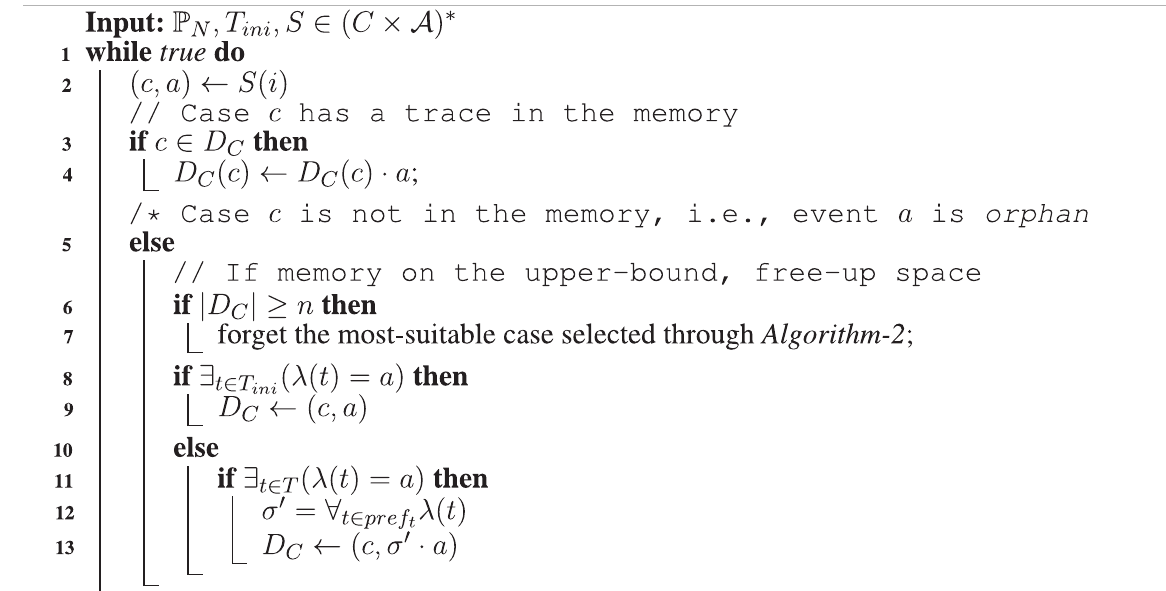
Algorithm 1 | Model-based pre fi x